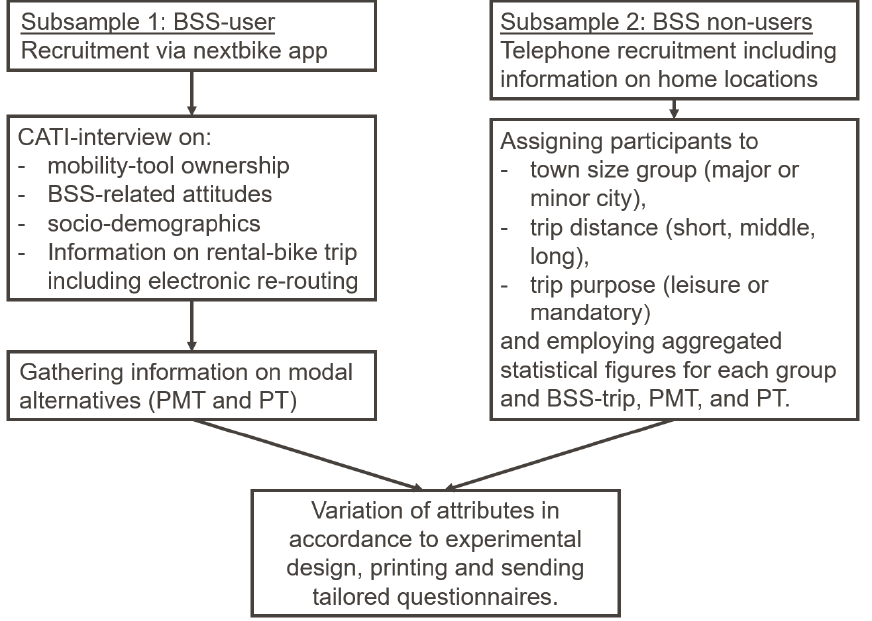
Figure 3. Schema of survey protocol.